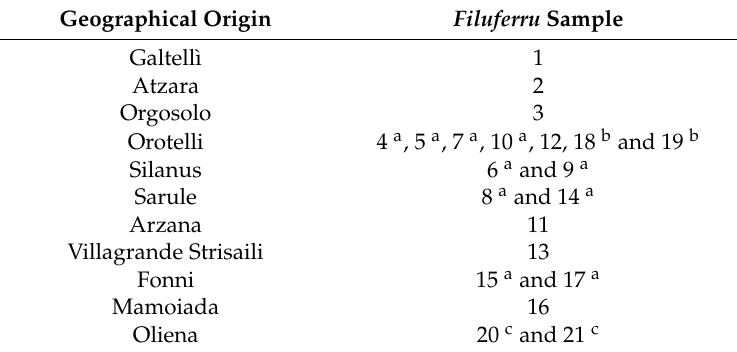
Table 1. Geographical origin of craft samples of Filuferru (1–21) that were considered in the study.